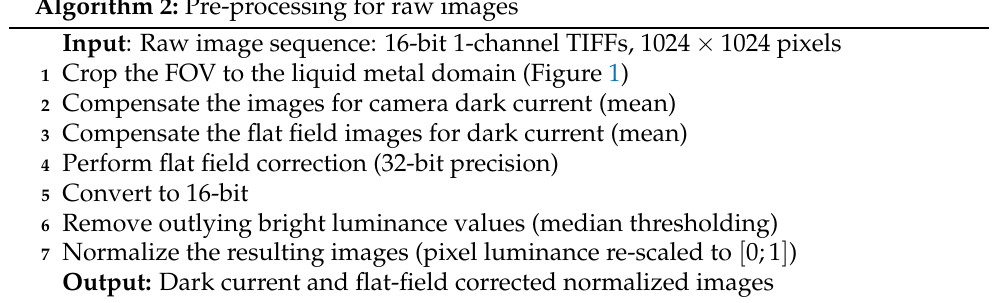
Algorithm 2: Pre-processing for raw